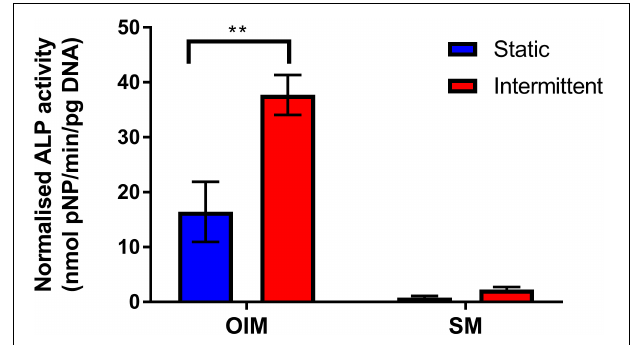
FIGURE 6 | Comparison of day 14 normalized ALP activity of bone microfluidic chips maintained with the intermittent flow profile in either OIM or SM. As with Figure 4 , ALP activity was significantly higher with intermittent flow on OIM. However, there was minimal ALP activity in chips maintained in SM, regardless of flow profile ( n = 4) (** p <